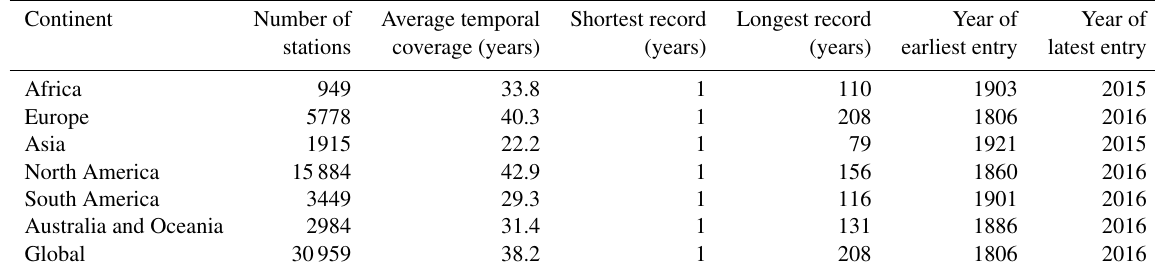
Table 6. Summary statistics of GSIM time series.